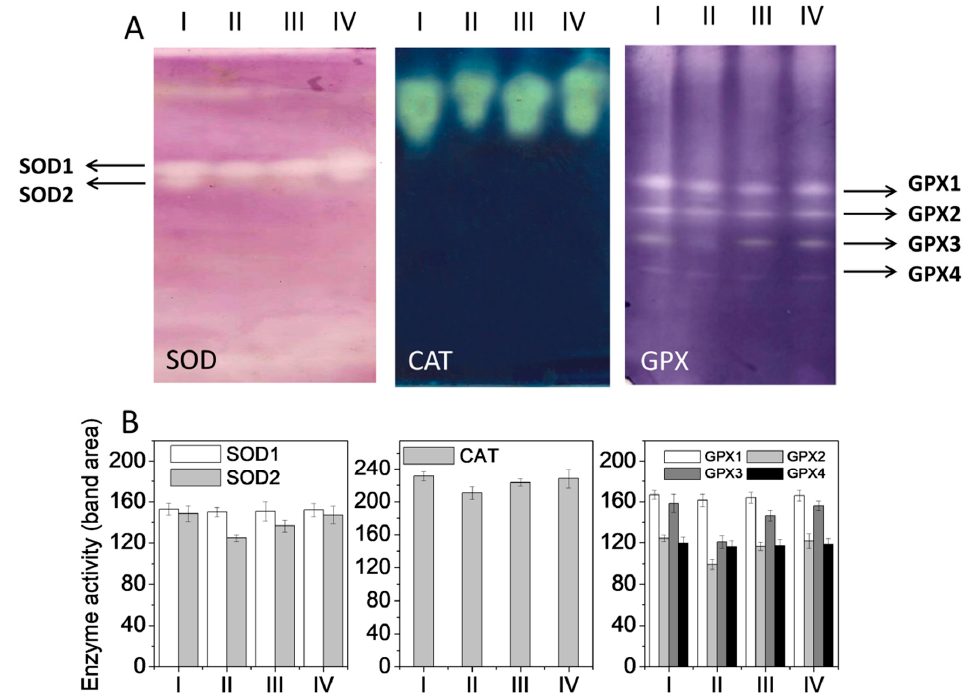
Figure 1. Effect of EEAB on the activity of antioxidant enzymes in the liver of CCl 4 -treated Electrophoretic pattern of antioxidant enzymes. ( B ) Densitometric analysis of antioxidant rats. (A) Electrophoretic pattern of antioxidant enzymes. (B) Densitometric analysis of antioxidant enzymes. Treatments—I: control. II: CCl 4 30%. III: EEAB (250 mg/kg) + CCl 4